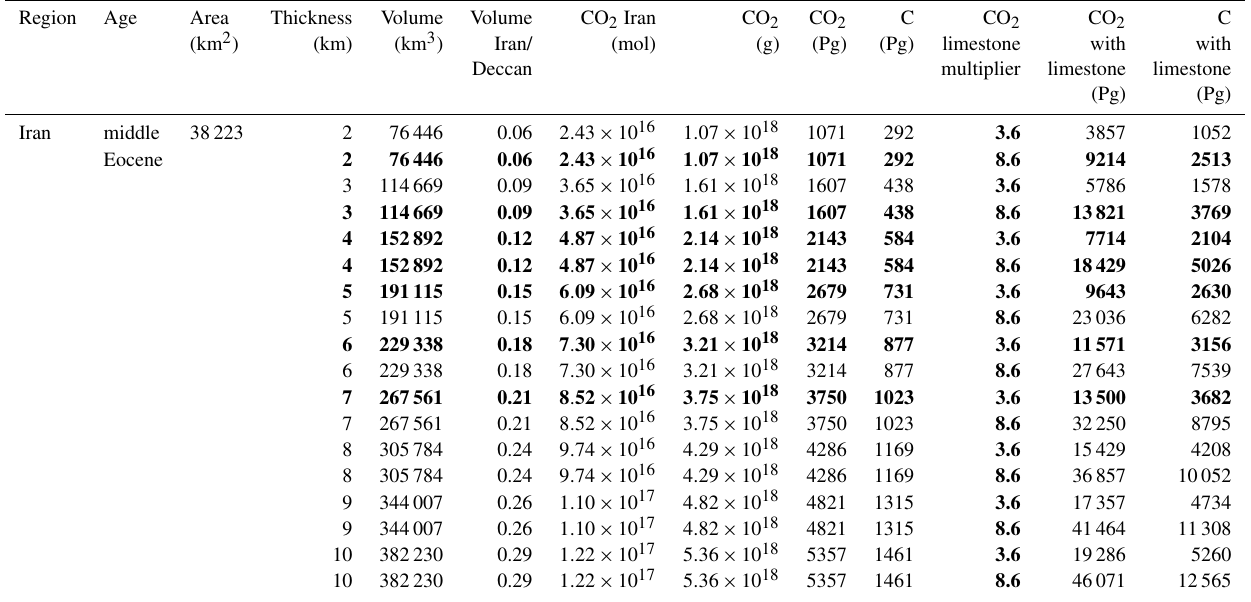
Table 2. Estimates for the amount of released carbon for different volumes of middle Eocene volcanic rocks in Iran. Estimates marked in bold are within estimates for the MECO (2000–4000PgC; Henehan et al., 2020; Sluijs et al., 2013; van der Ploeg et al., 2018). Region